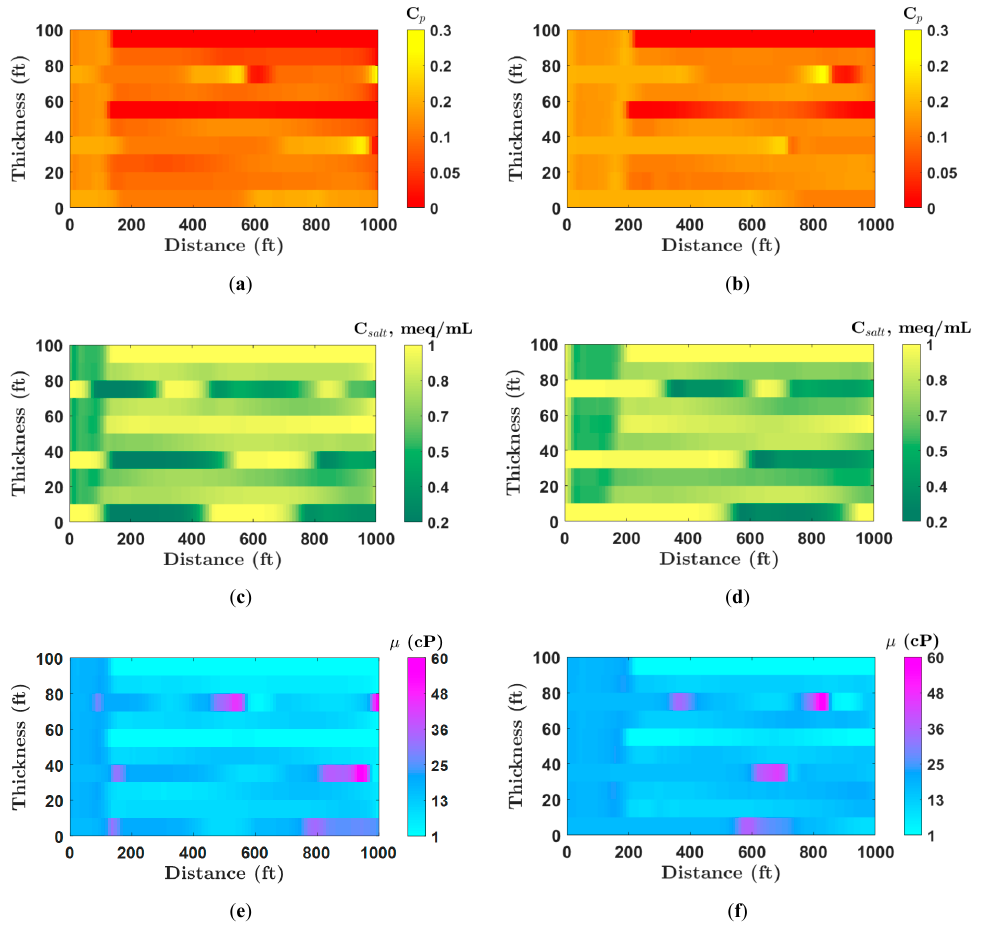
Figure 6. Water salinity ( a ), and aqueous phase viscosity ( b ) profiles versus distance for the slug- based (green) and continuous (red) polymer schemes in layer eight (middle) at